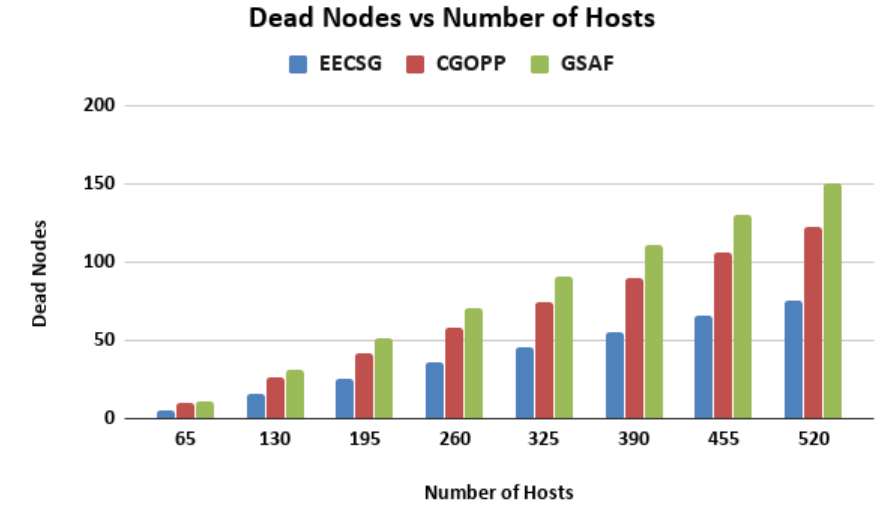
Figure 4. Number of dead nodes vs. number of hosts.